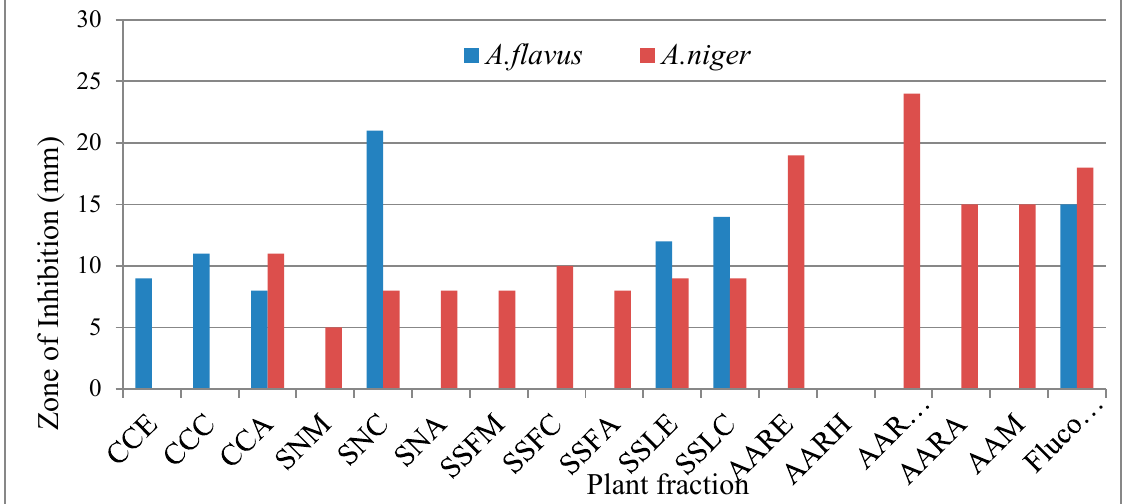
Figure 5. Graph of antifungal activity of plant extracts.